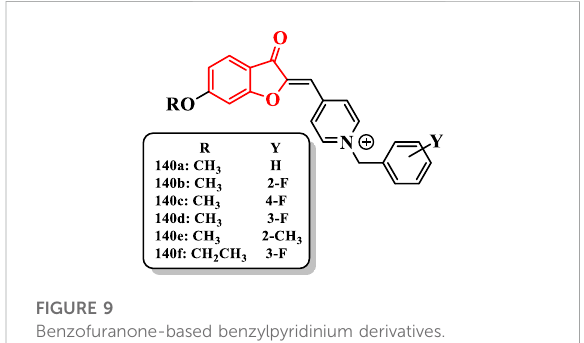
FIGURE 9 Benzofuranone-based benzylpyridinium